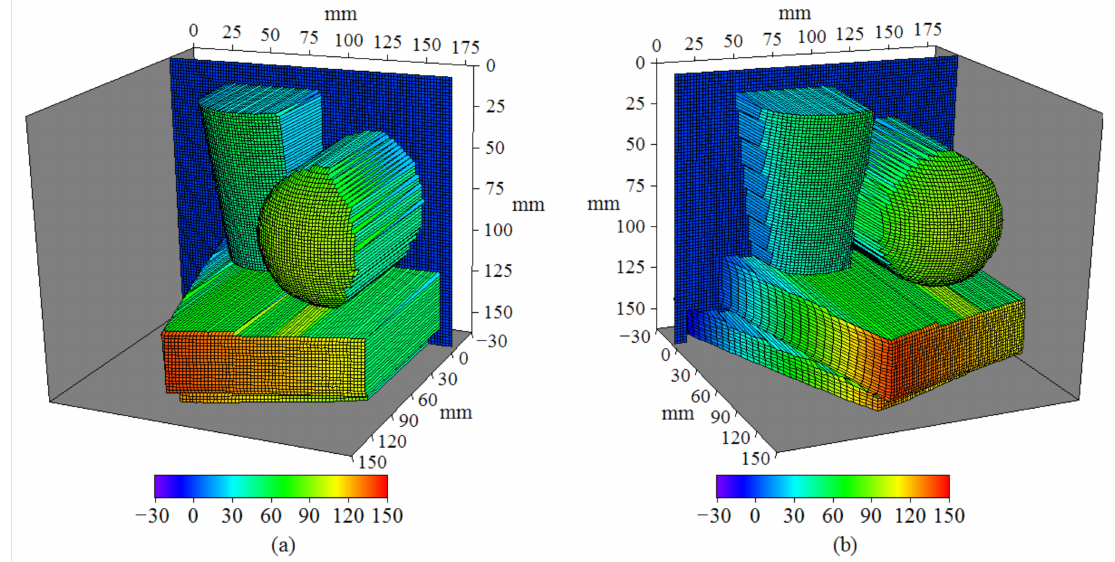
Figure 18. ( a ) The retrieved profile. ( b ) The retrieved profile as observed from another view